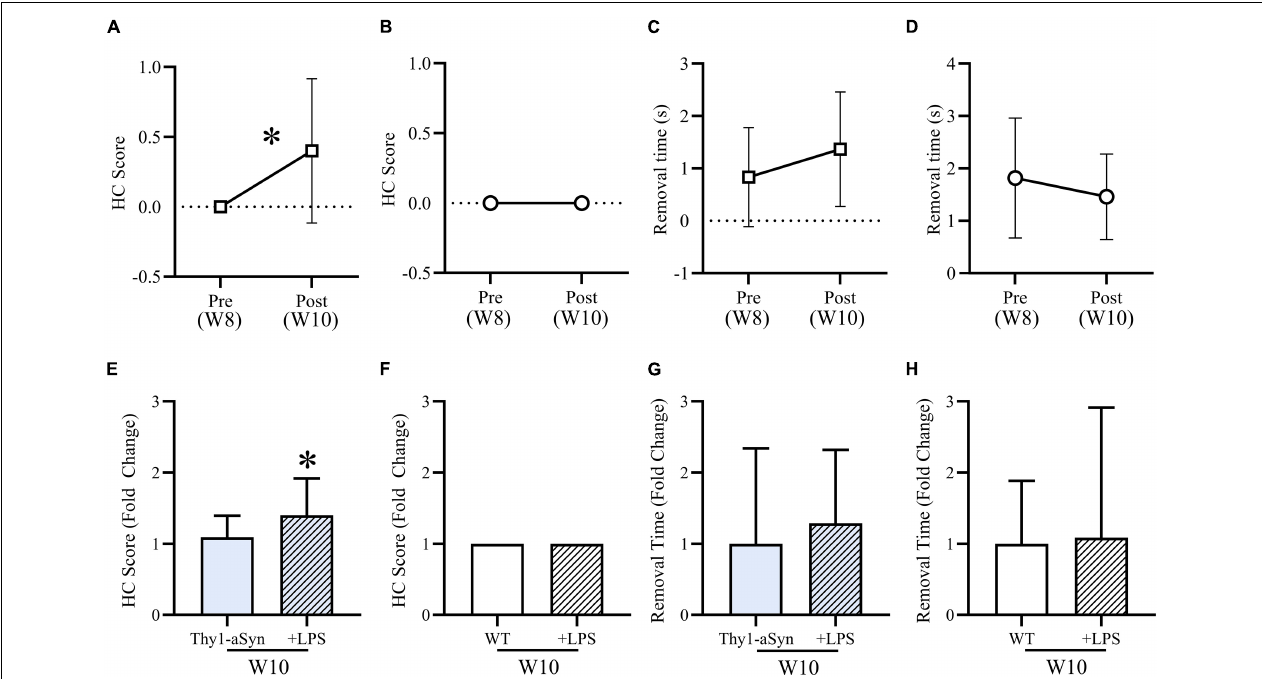
FIGURE 5 | LPS treatment mildly exacerbates motor impairments in Thy1- α Syn mice. After LPS consumption (10 µ g/ml) in drinking water for 12 nights, mean hindlimb clasp reflex (HC) score was significantly higher than baseline (A) and compared to untreated Thy1- α Syn mice (E) , while WT scores remained normal at all time points (B,F) . Mean adhesive removal time for Thy1- α Syn mice demonstrated a non-significant increase compared to baseline (C) , however, was lower than untreated 10-week-old Thy1- α Syn mice (G) . LPS-treated WT mice were non-significantly faster than baseline (D) and slightly slower than untreated animals at 10-week old (H)